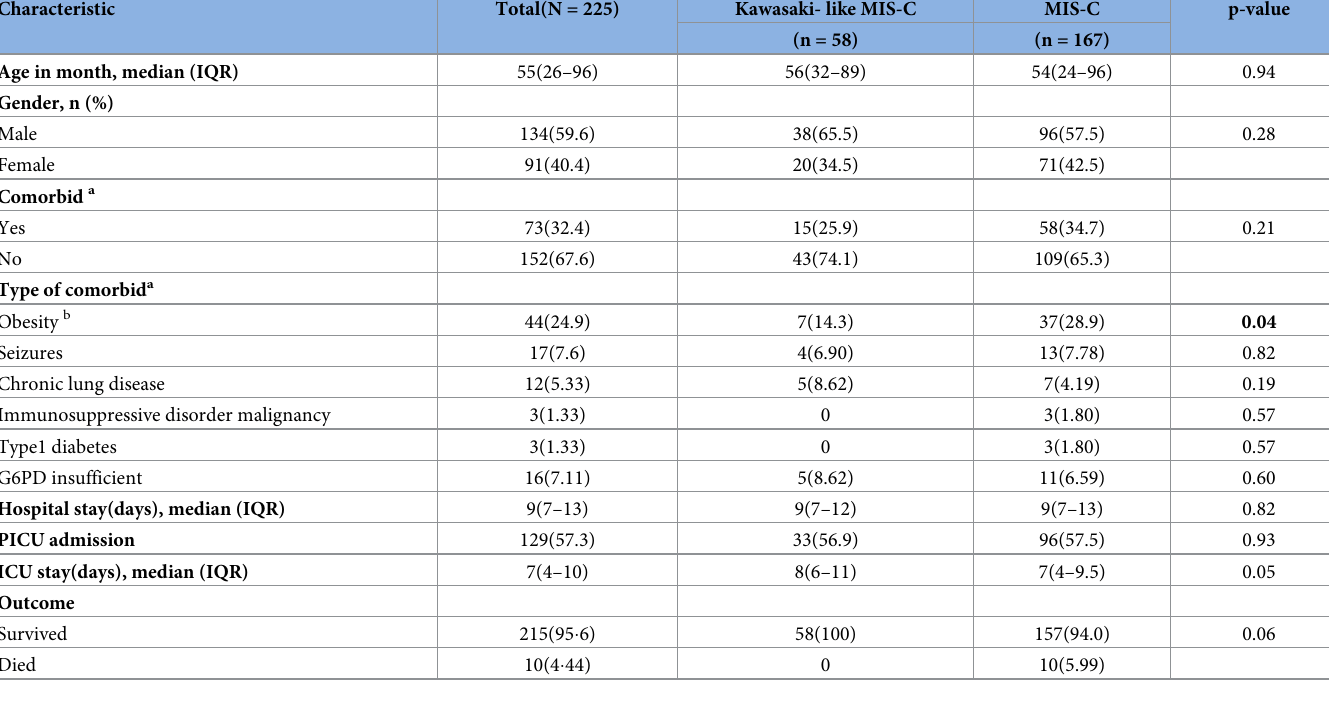
Table 1. The baseline characteristics and clinical outcome in MIS-C and Kawasaki- like